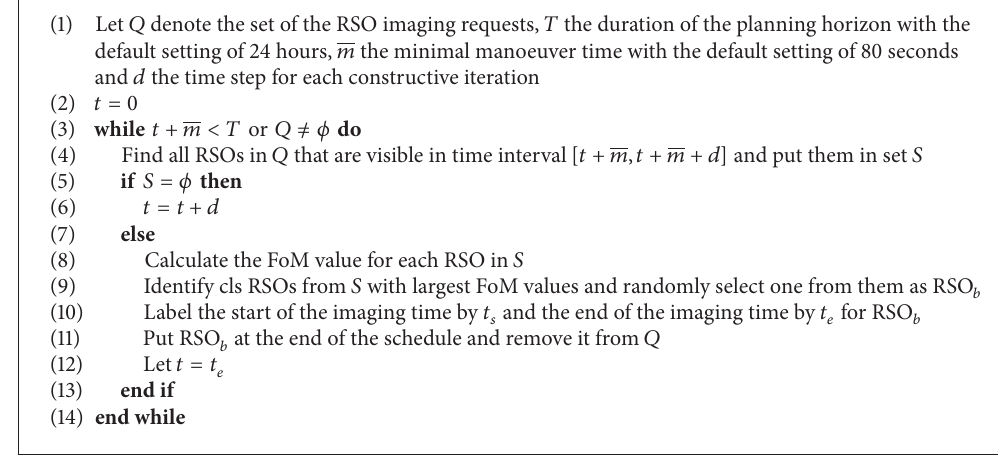
Algorithm 2: Pseudocode of the randomized greedy